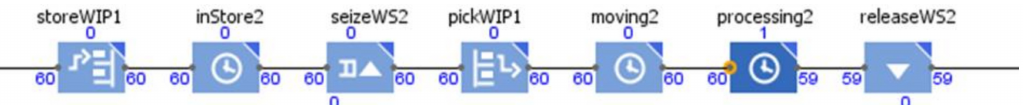
Figure 3. Logic model for work in process part storage (storeWIP), moving and processing (repeated for each workstation).